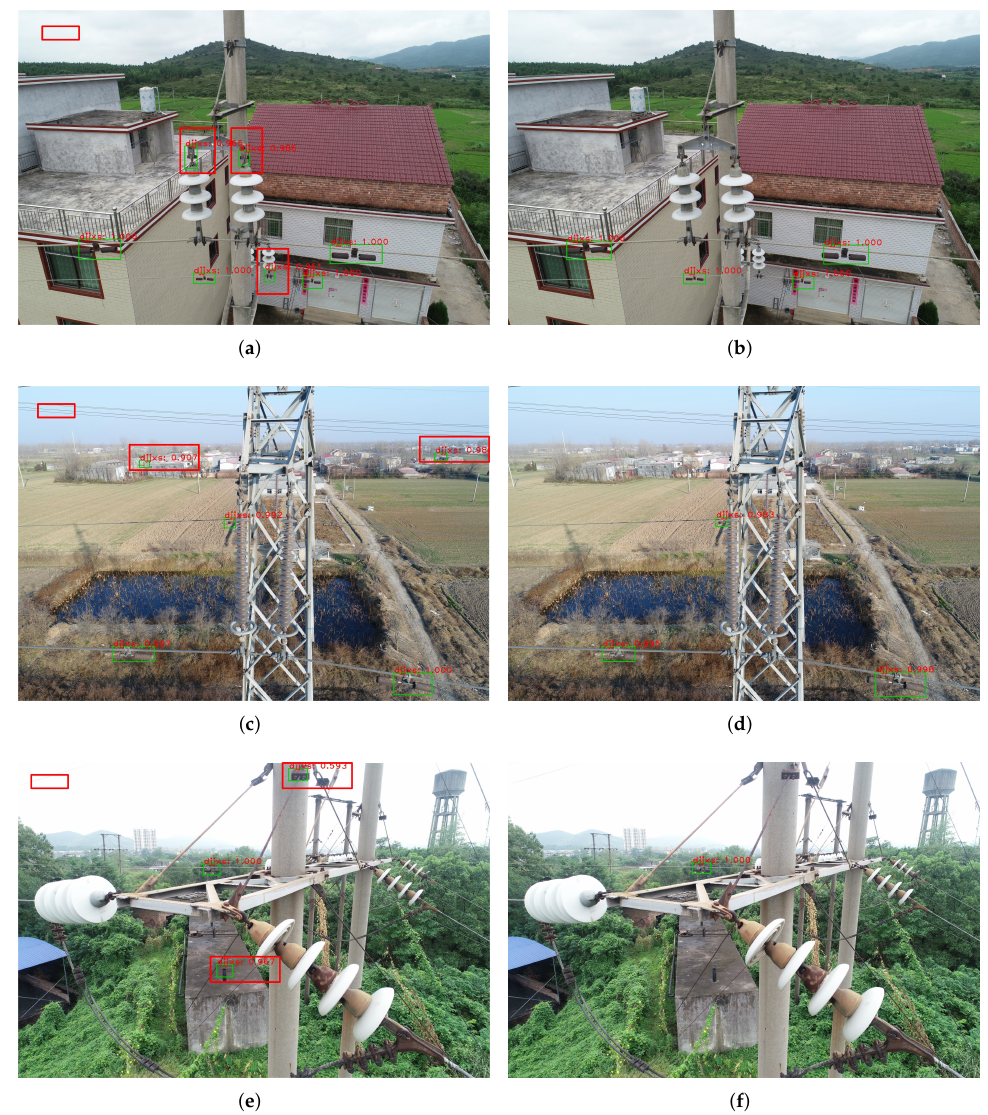
Figure 13. Comparative results for evaluating the feature enhancement mechanism, where ( a , c , e ) are the results without the mechanism, ( b , d , f ) are the results of using the